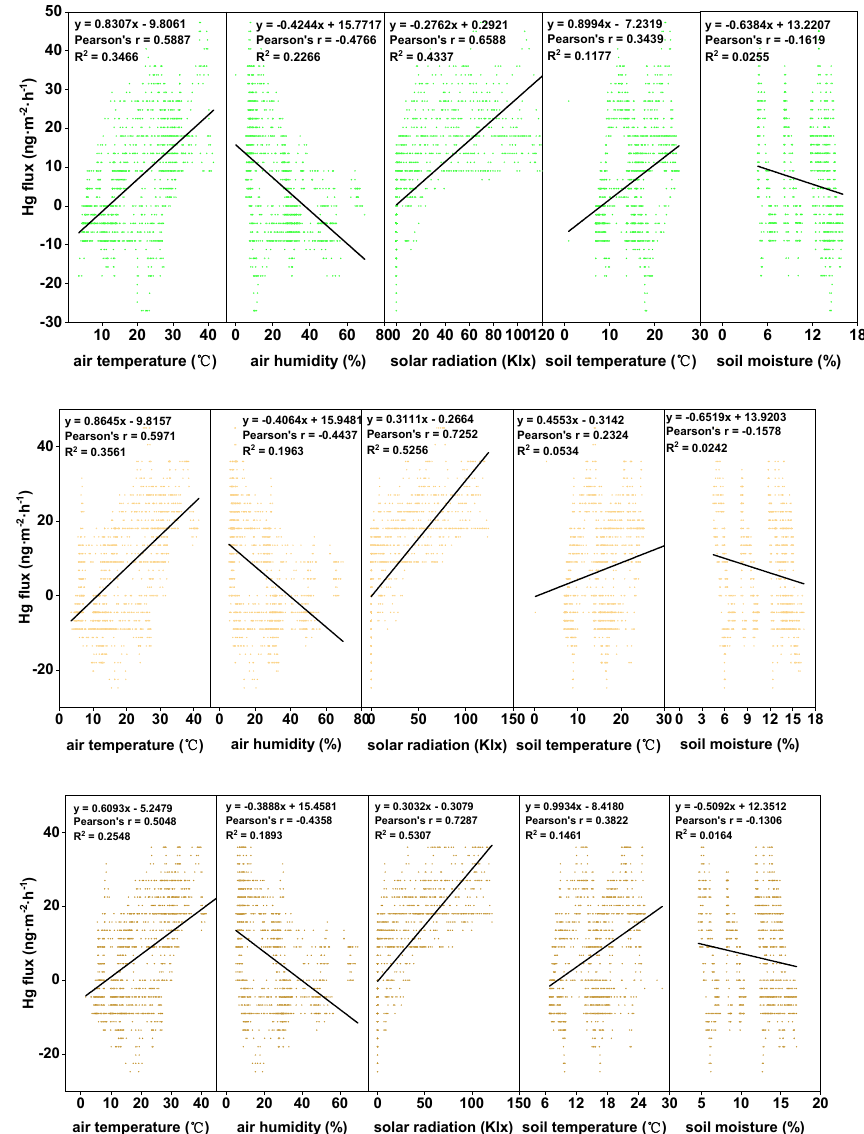
Figure 5. Correlation between the diurnal GEM fluxes with meteorological factors, such as air/soil temperatures, solar radiation, and air/soil humidity levels for the three examined conditions during the entire growing season from top to bottom: Anethifolia cover; Anethifolia removal; and bare soil. Table 4. The Pearson’s correlation between Hg fluxes and environmental variables under three treatments. forbs